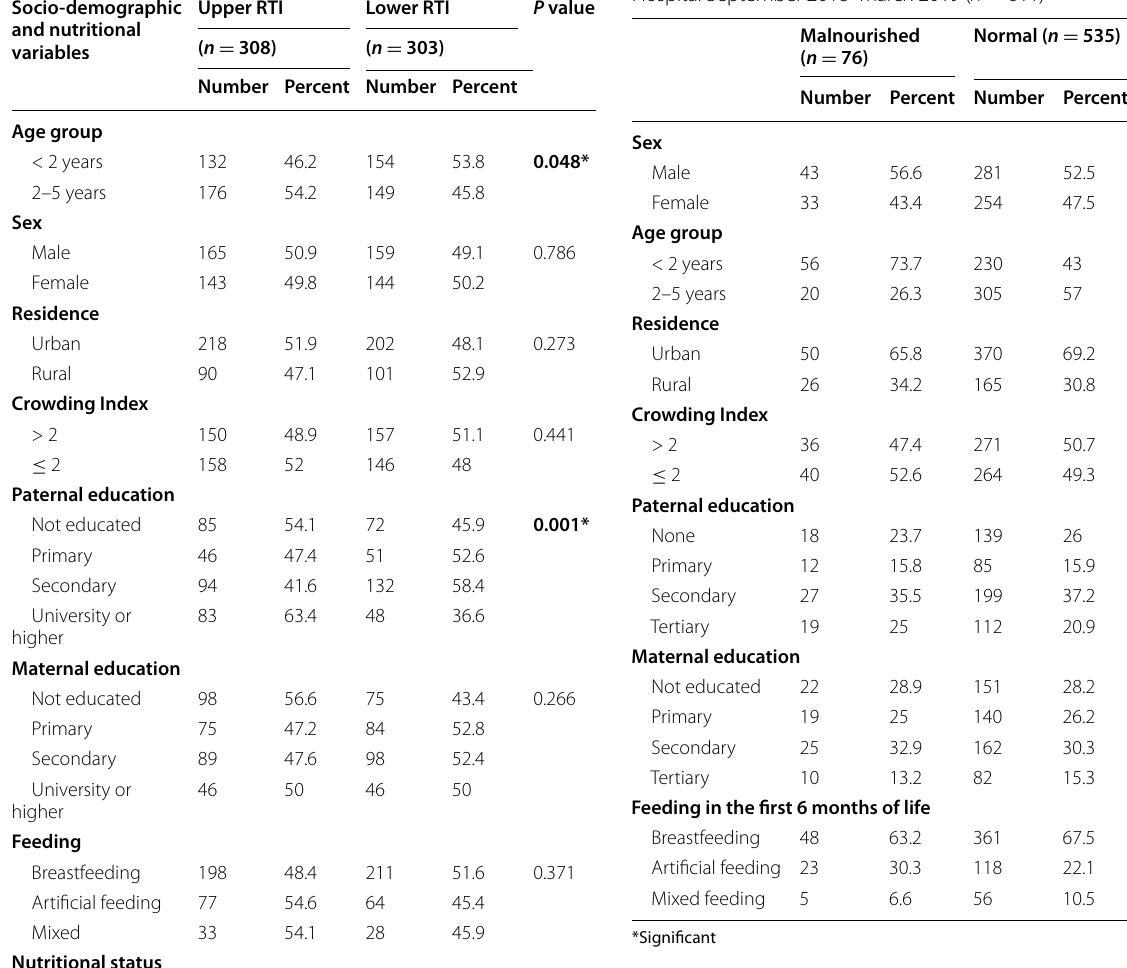
Table 2 Socio‑demographic and nutritional differences associated with upper and lower RTI patients under 5 years of age, Cairo